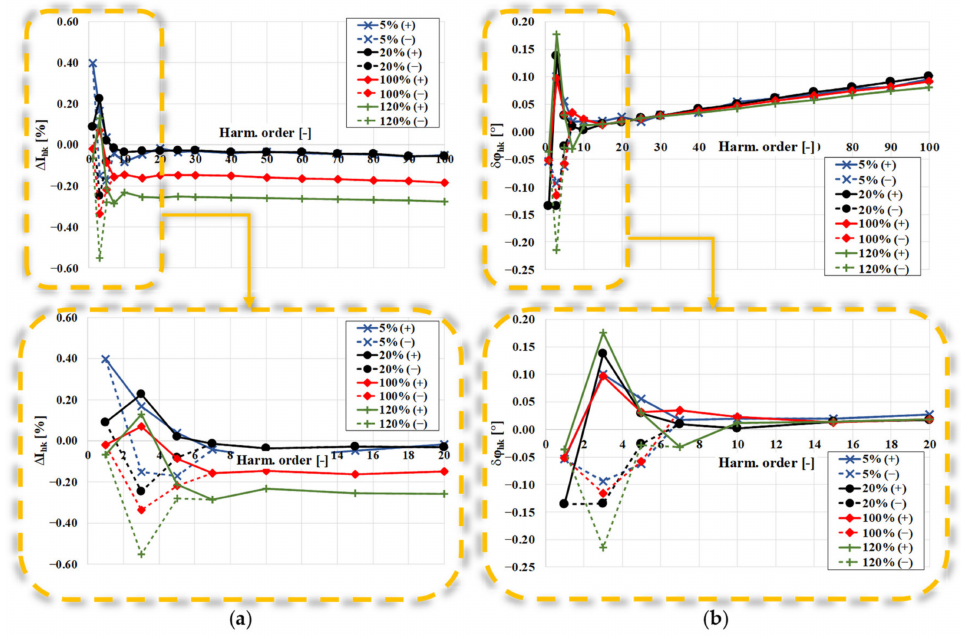
Figure 5. The frequency characteristics of the values of the current error ( a ) and phase displacement ( b ) of the tested ECT for the resistive load equal to 100 Ω